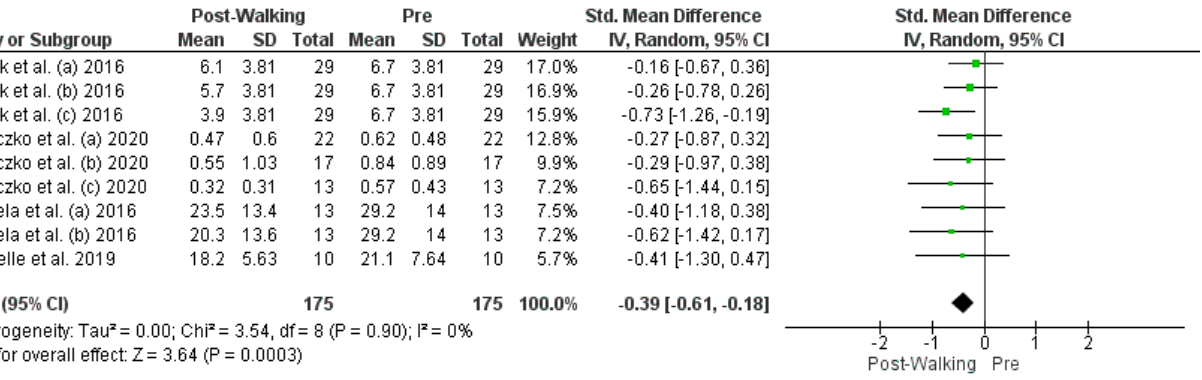
Figure 2. Depression Post- vs. Pre-Nature Walk Forest Plot [9,10,13,14]. Green squares represent standardized mean difference for each study, while black rhombus represents the aggregated average of the standardized mean differences.